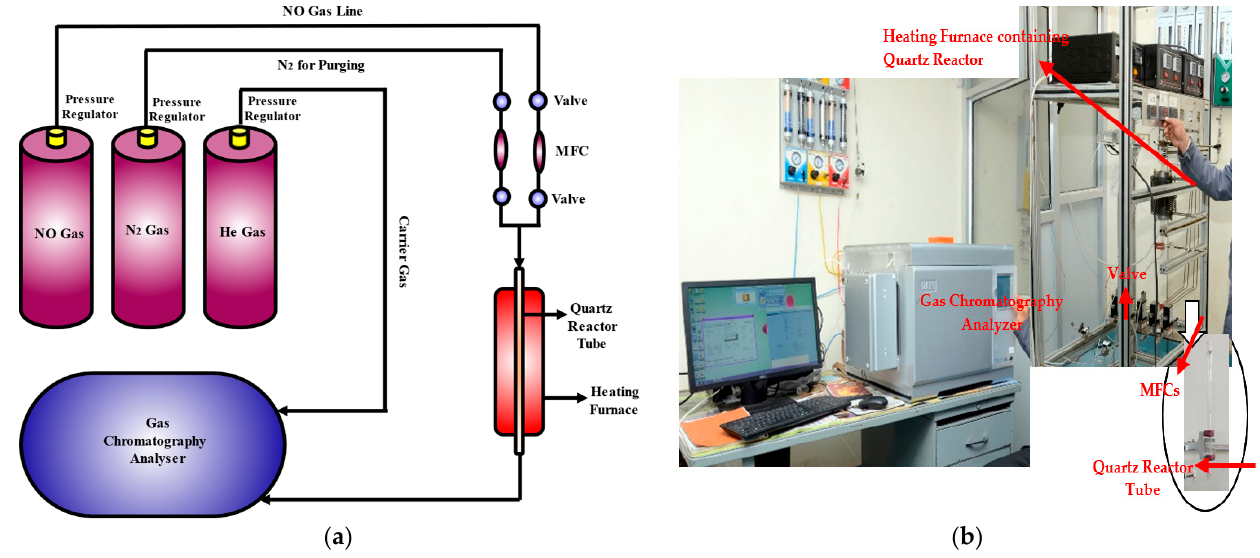
Figure 1. ( a ) Schematic of the experimental setup, ( b ) Experimental setup used for NO conversion investigations.